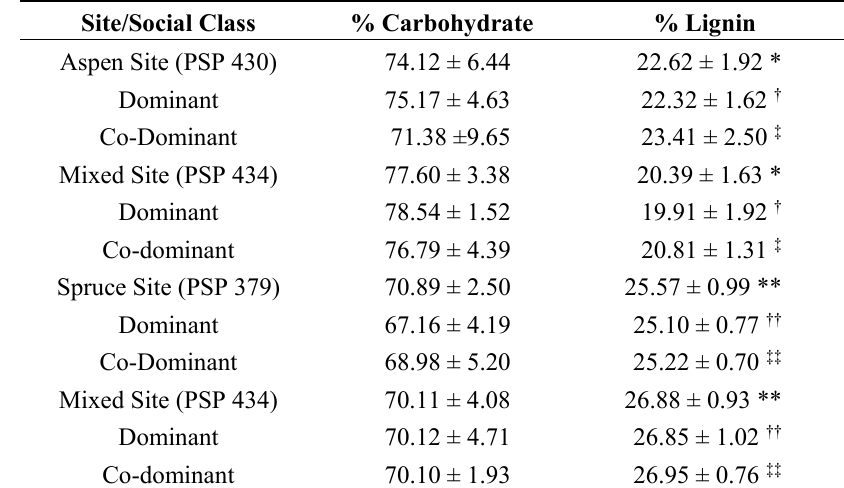
Table 4. Xylem cell wall carbohydrate and lignin content (%) per site and social class ( n = 30 samples per